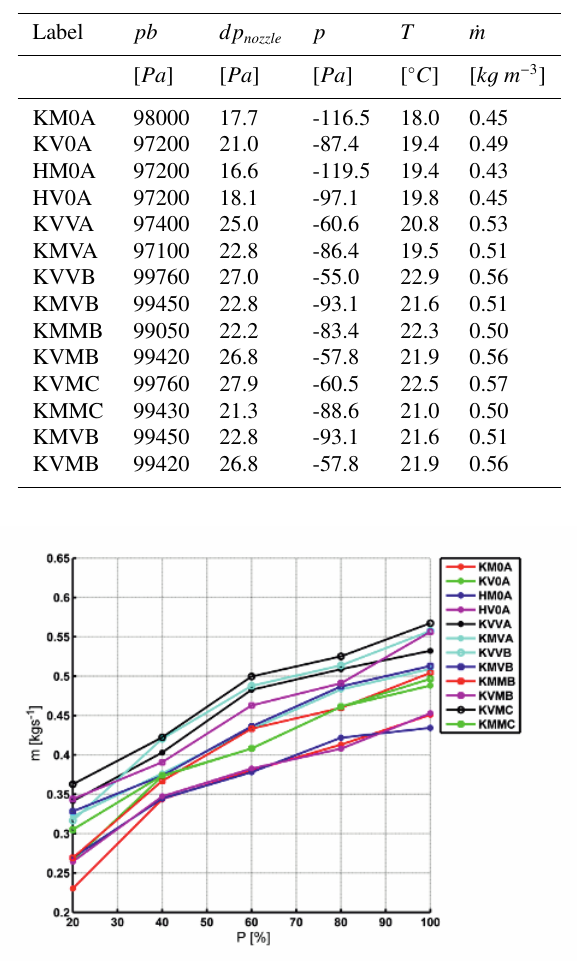
Fig. 5. Mass flow rate for each configuration and di ff erent fans performance